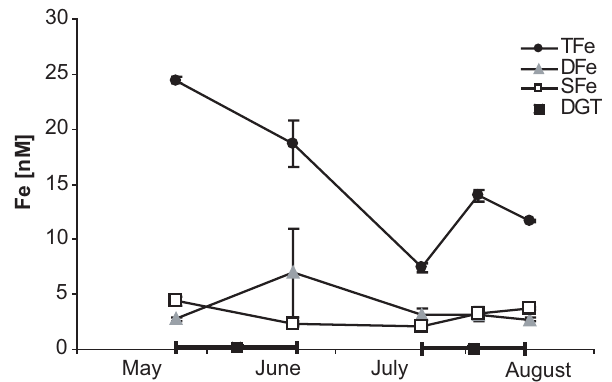
Fig. 13. Temporal variations of TFe (total Fe), DFe ( < 0.22µm), SFe ( < 1kDa) and DGT-labile Fe ([Fe] DGT ) at the Gotland Deep station (BY15) euphotic zone. For DGT measurements, the vertical lines indicate the time period for the measurement, and the filled square represent the